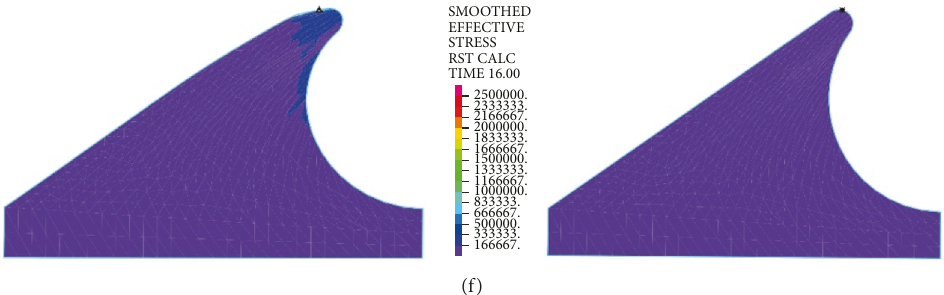
Figure 11: Effective stress distribution of the rubber rings before optimizing during clockwise rotation. (a) Deflection 0.2 ° . (b) Deflection 0.4 ° . (c) Deflection 0.6 ° . (d) Deflection 0.8 ° . (e) Deflection 1.0 ° . (f) Deflection 1.2 °